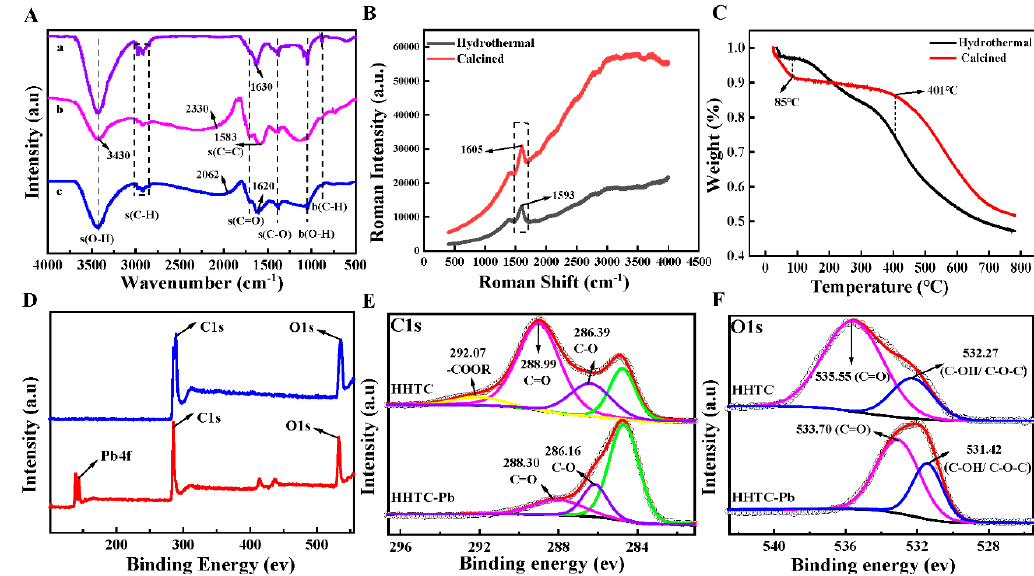
Figure 2. ( A ) FT-IR spectrum before (a) hydrothermal, (b) calcined and after (c) HHTB adsorption of